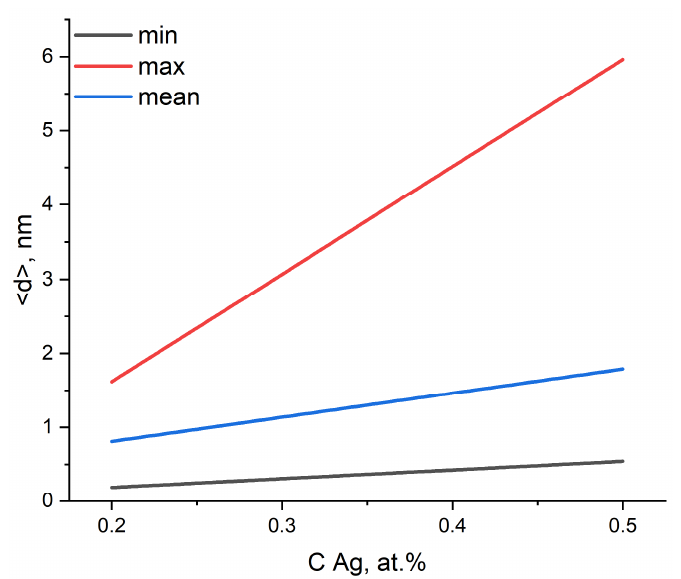
Figure 7. SEM image of the microstructure and EDS mapping of the element composition of the pure silver phase in the porous TiNi + 0.5% Ag alloy.